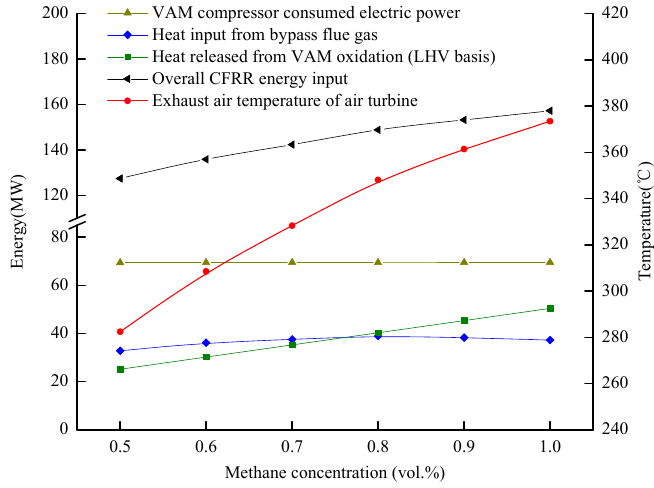
Figure 5. Influence of the methane concentration on the temperature of exhaust air and energy distribution within the VAM-based hot air power cycle.